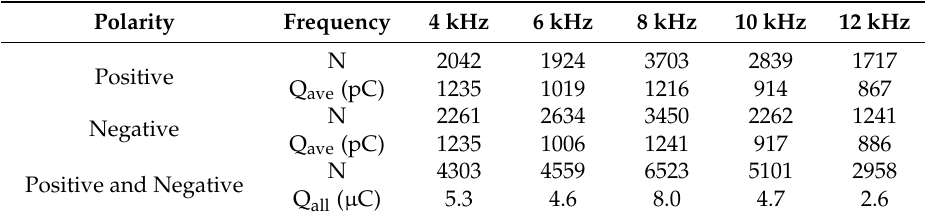
Table 2. Partial discharge characteristic parameters.